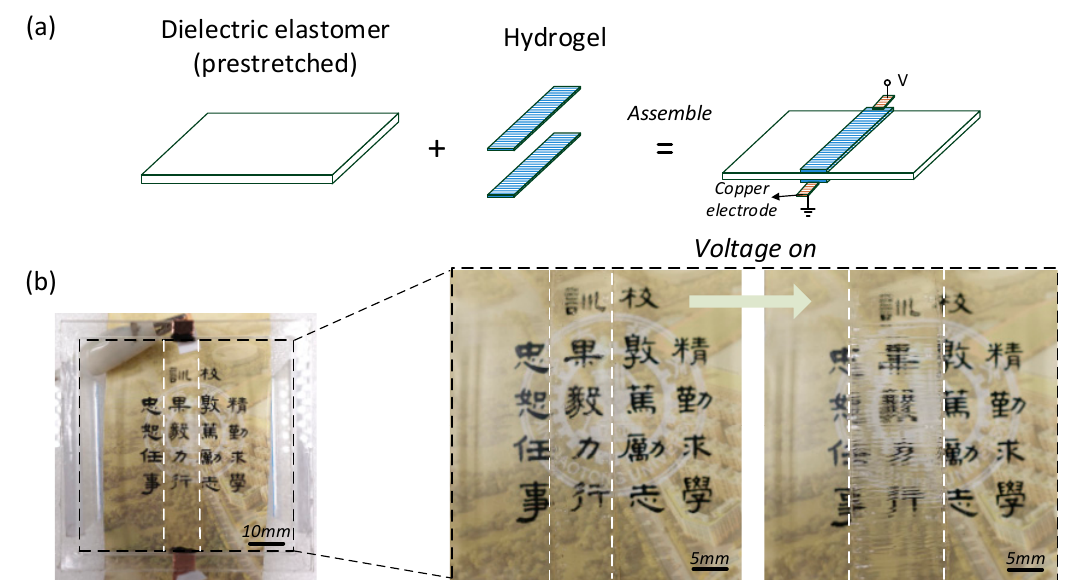
Figure 3. Hydrogels are attached to pre-stretched dielectric elastomer, consisting of a soft and fully transparent tri-layer laminate. After applying voltage, the hydrogel deforms and wrinkles. ( a ) Fabrication process of the actuator. ( b ) Blurring effect in optics. The white dash box showing the area which is covered with hydrogel.